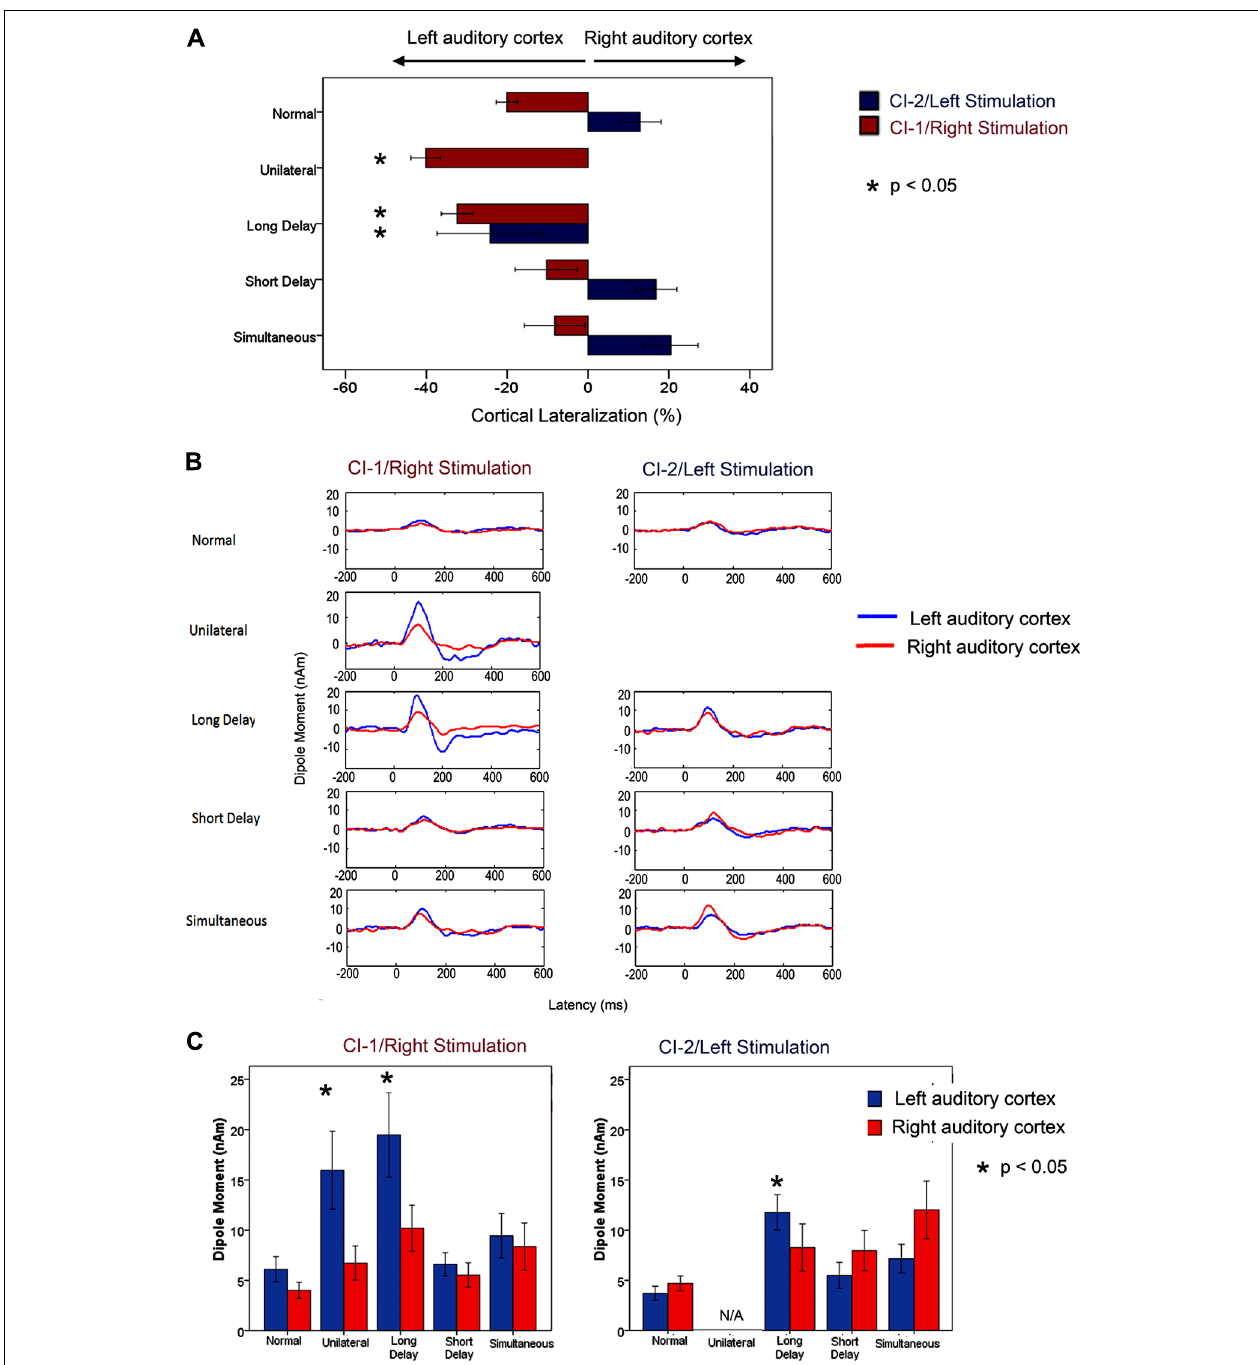
FIGURE 3 | Re-printed with permission from Gordon etal. (2013). “ (A) Per cent cortical lateralization (mean ± 1 standard error) is plotted for each participant group. Greater than normal contralateral lateralization to right/CI-1 stimuli was found in long delay and unilateral cochlear implant users ( p < 0.05 and < 0.0001, respectively) but not in short delay and simultaneous groups ( p > 0.05).The long delay group showed a decrease in contralateral lateralization/increase in ipsilateral lateralization relative to those with normal hearing in response to left/CI-2 stimulation.This did not occur in the short delay and simultaneous groups. (B) Grand mean virtual sensor data for left